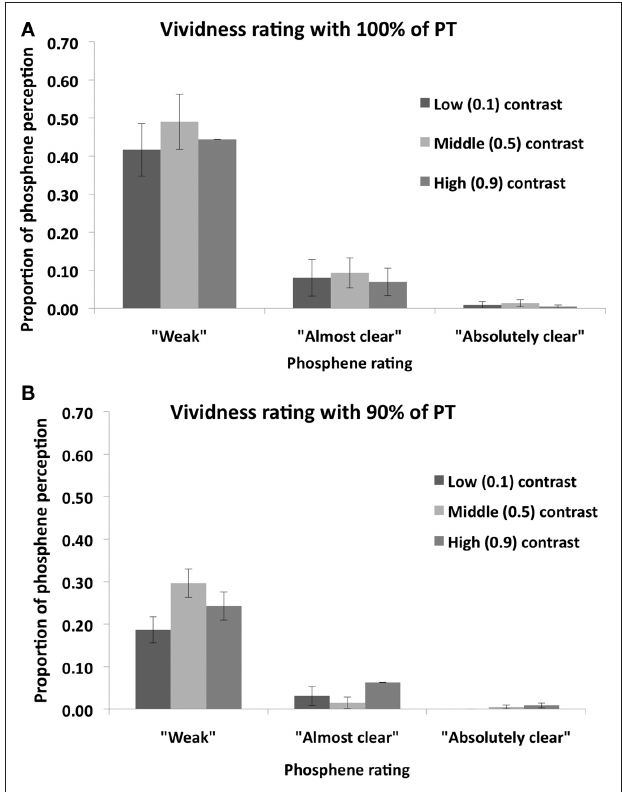
Figure 5 | Mean ( n = 8) vividness ratings of perceived phosphenes in experiment 2 for (A) 100% PT condition; and (B) 90% PT condition. Error bars represent ± 1